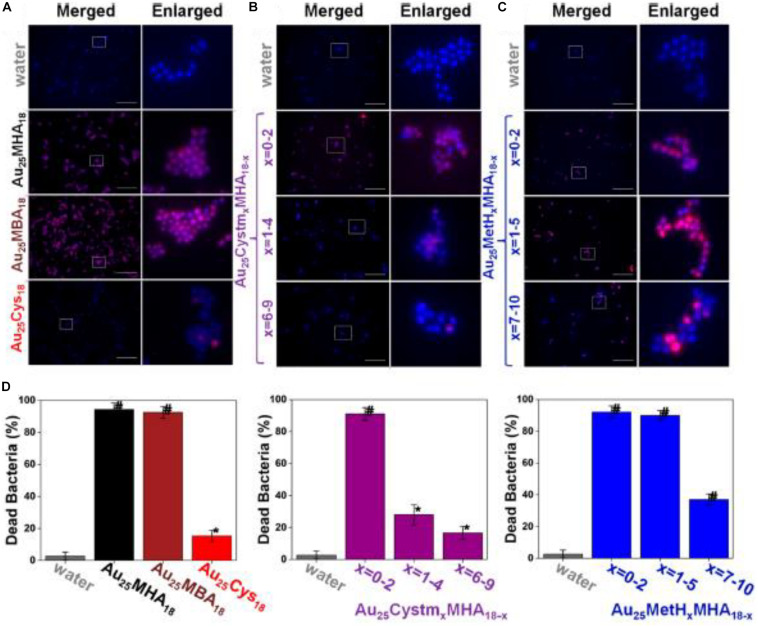
Au25 NCs protected by thiolate ligands bearing a higher ratio of –CO2H groups showed better bacterial killing efficiency. (A–C) Merged and enlarged representative fluorescence images of the S. aureus after 2 h treatment of Au25 NCs. (D) Percentage of the dead S. aureus after being treated with different ligand-protected Au25 NCs for 2 h. *Significant against the water-treated group, p < 0.05; #Significant against the water-treated group, p < 0.001. Reproduced with permission, copyright 2018, American Chemical Society.